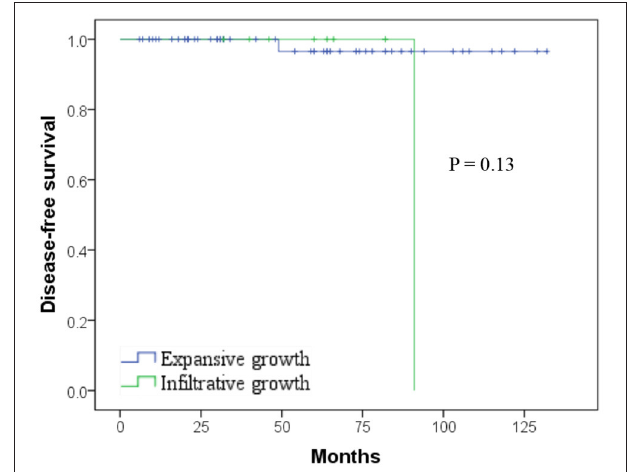
FIGURE 2 | Kaplan–Meier curves showing no difference in disease-free survival (DFS) after surgery for solid pseudopapillary neoplasm (SPN) according to the microscopic infiltrative/expansive growth pattern ( p =